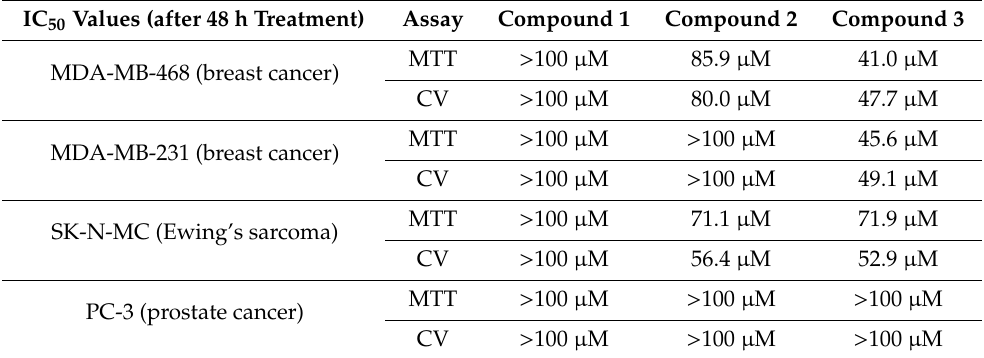
Table 3. IC 50 values of the anti-proliferative and cytotoxic e ff ects of compounds 1 , 2 , and 3 as determined after 48 h treatment of breast cancer MDA-MB-468 and MDA-MB-231 cells, Ewing’s sarcoma SK-N-MC cells, and prostate cancer PC-3 cells by using MTT and CV (crystal violet) assays, respectively. IC 50 Values (after 48 h Treatment)